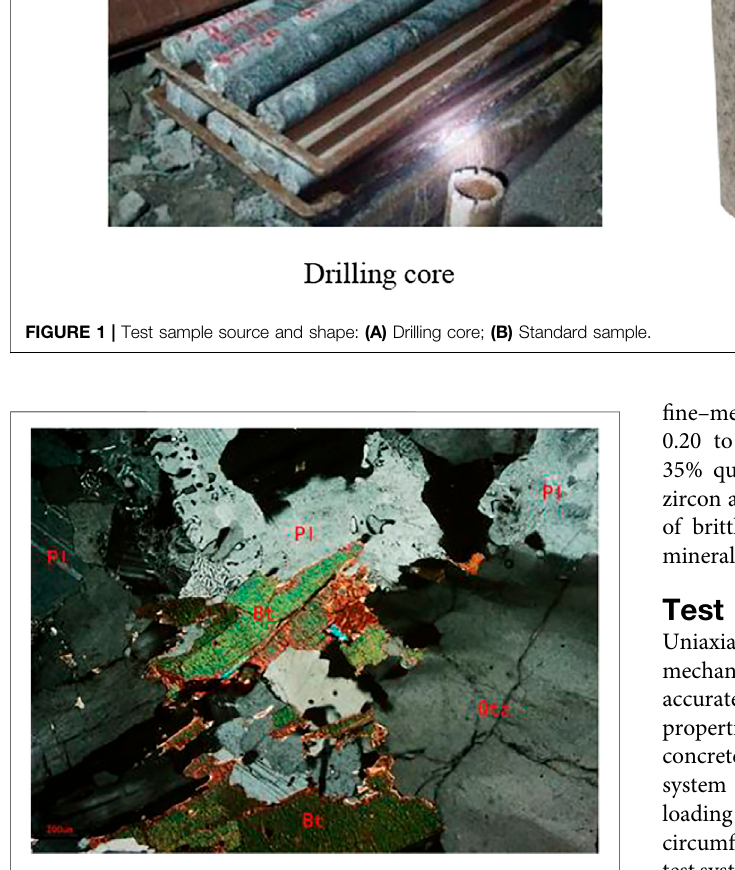
FIGURE 2| Mineral composition of the granite sample under apolarized light microscope.